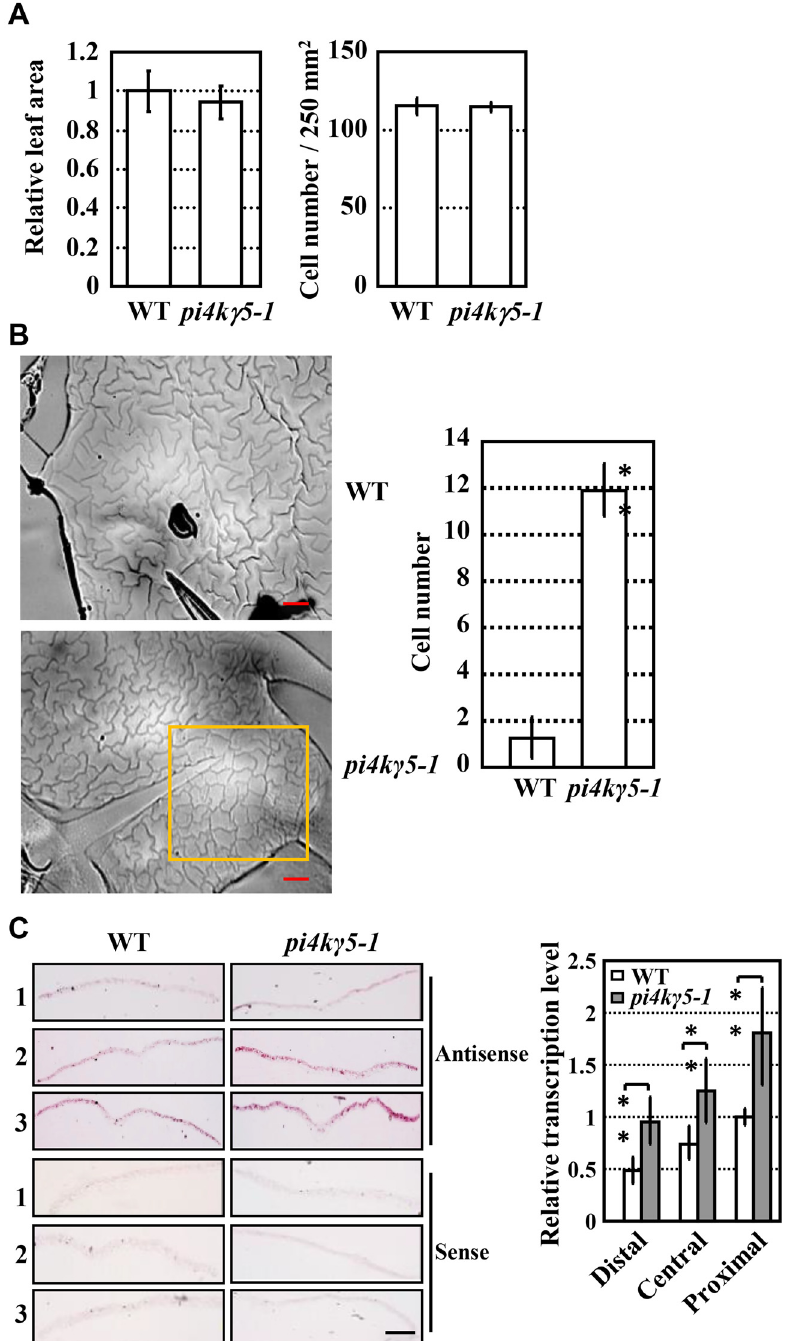
Fig 3. Enhanced cell division at serration tip of pi4k γ 5 – 1 plants. A. pi4k γ 5 – 1 plants present similar leaf area (left) and cell numbers (right) compared to those of WT. Palisade cell numbers of same leaf area (250 mm 2 ) were measured and statistically analyzed (no significant difference). The experiments were repeated three times and data are presented as means ± SD (n = 20). B. Observation by differential interference contrast microscope (left, bars = 200 μ m) and measurement (right) revealed more epidermal cells at premature state (without interdigitated growth) in pi4k γ 5 – 1 leaves compared to WT (highlighted by squares). The 7 th and 8 th leaves of 18-day-old plants were measured and statistically analyzed ( ** , p < 0.01). The experiments were repeated three times and data are presented as means ± SD (n = 30). C. In situ RNA hybridization analysis (left, bars = 1 mm) and qPCR analysis (right) confirmed the enhanced H4 mRNA